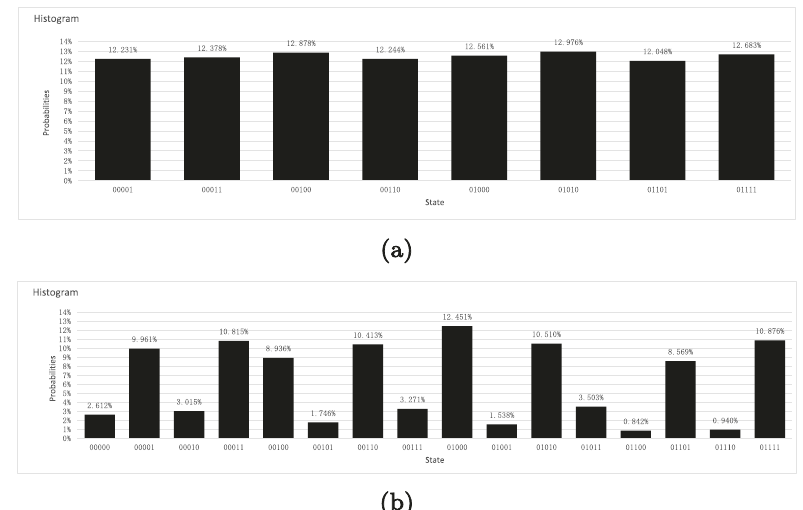
Fig. 3 The probability results of quantum circuit after four measurements in Z-basis. a is on simulator and b is on ibmqx